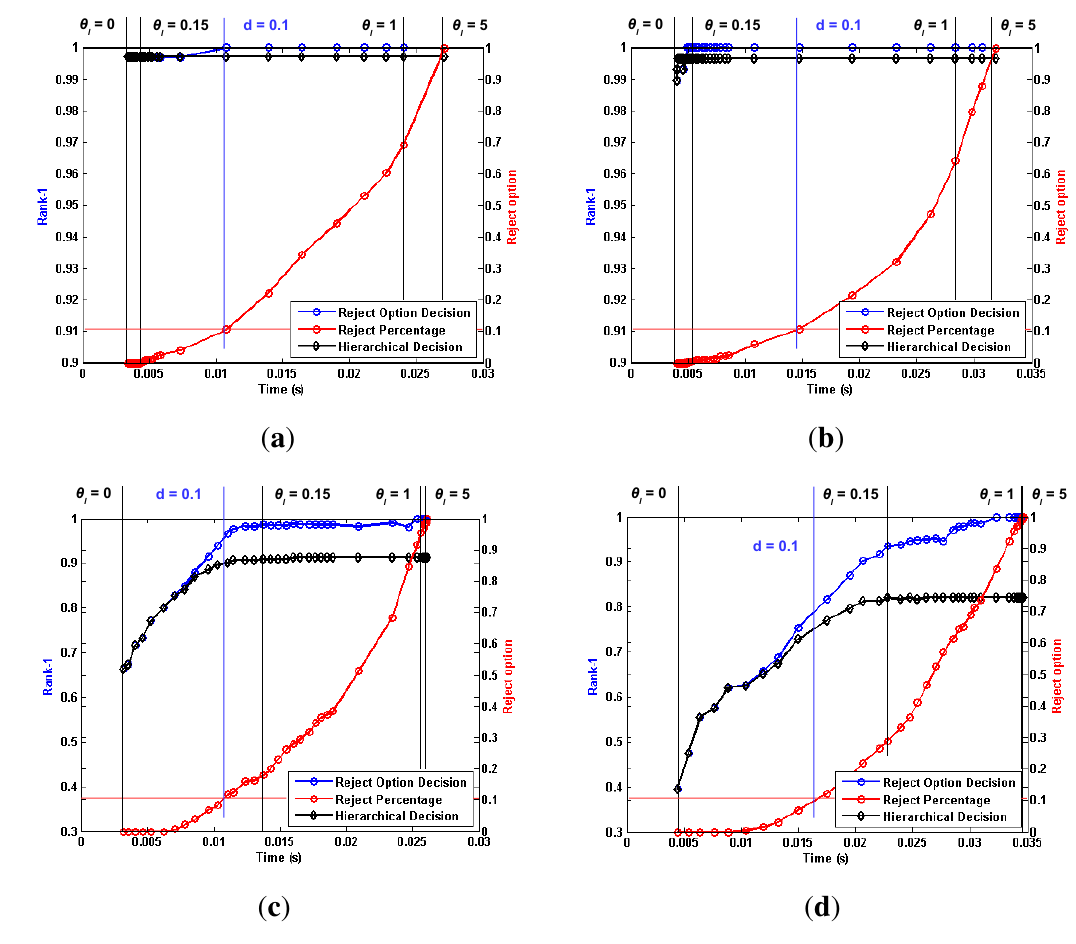
Figure 6. Main results obtained with the proposed methodology for Subsets 2–5 of the Extended Yale B Face database.